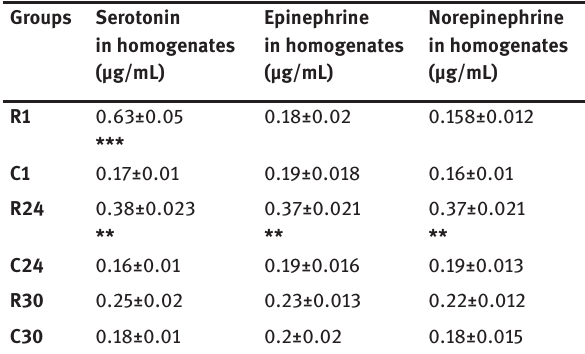
Table 1: Changes of serotonin, epinephrine, norepinephrine